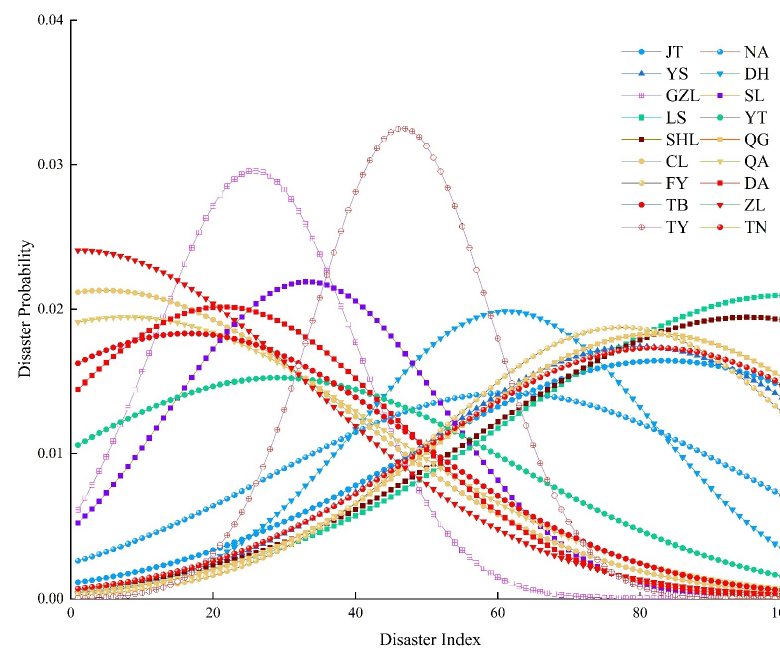
Figure 6. Drought probability density under different disaster index.